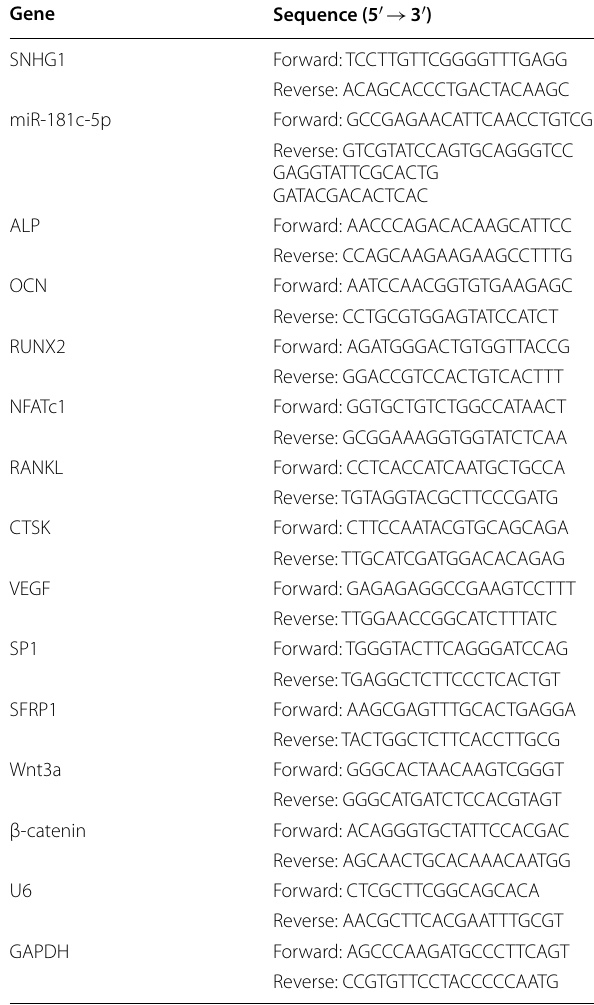
Table 1 Primers used for qPCR